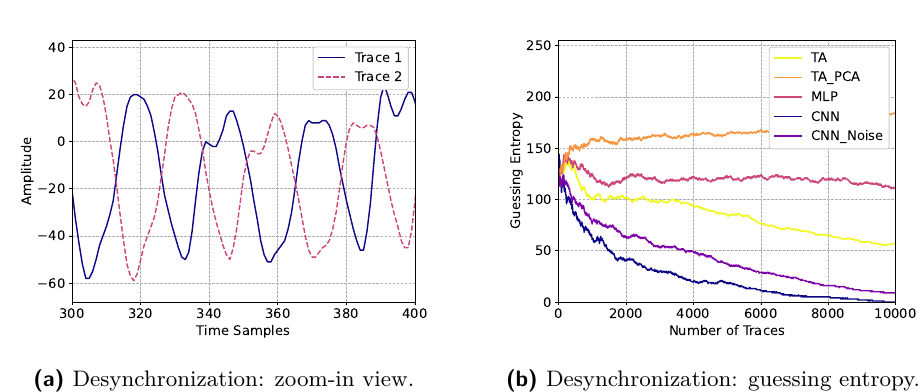
Figure 3: Desynchronization: demonstration and its influence on guessing entropy.